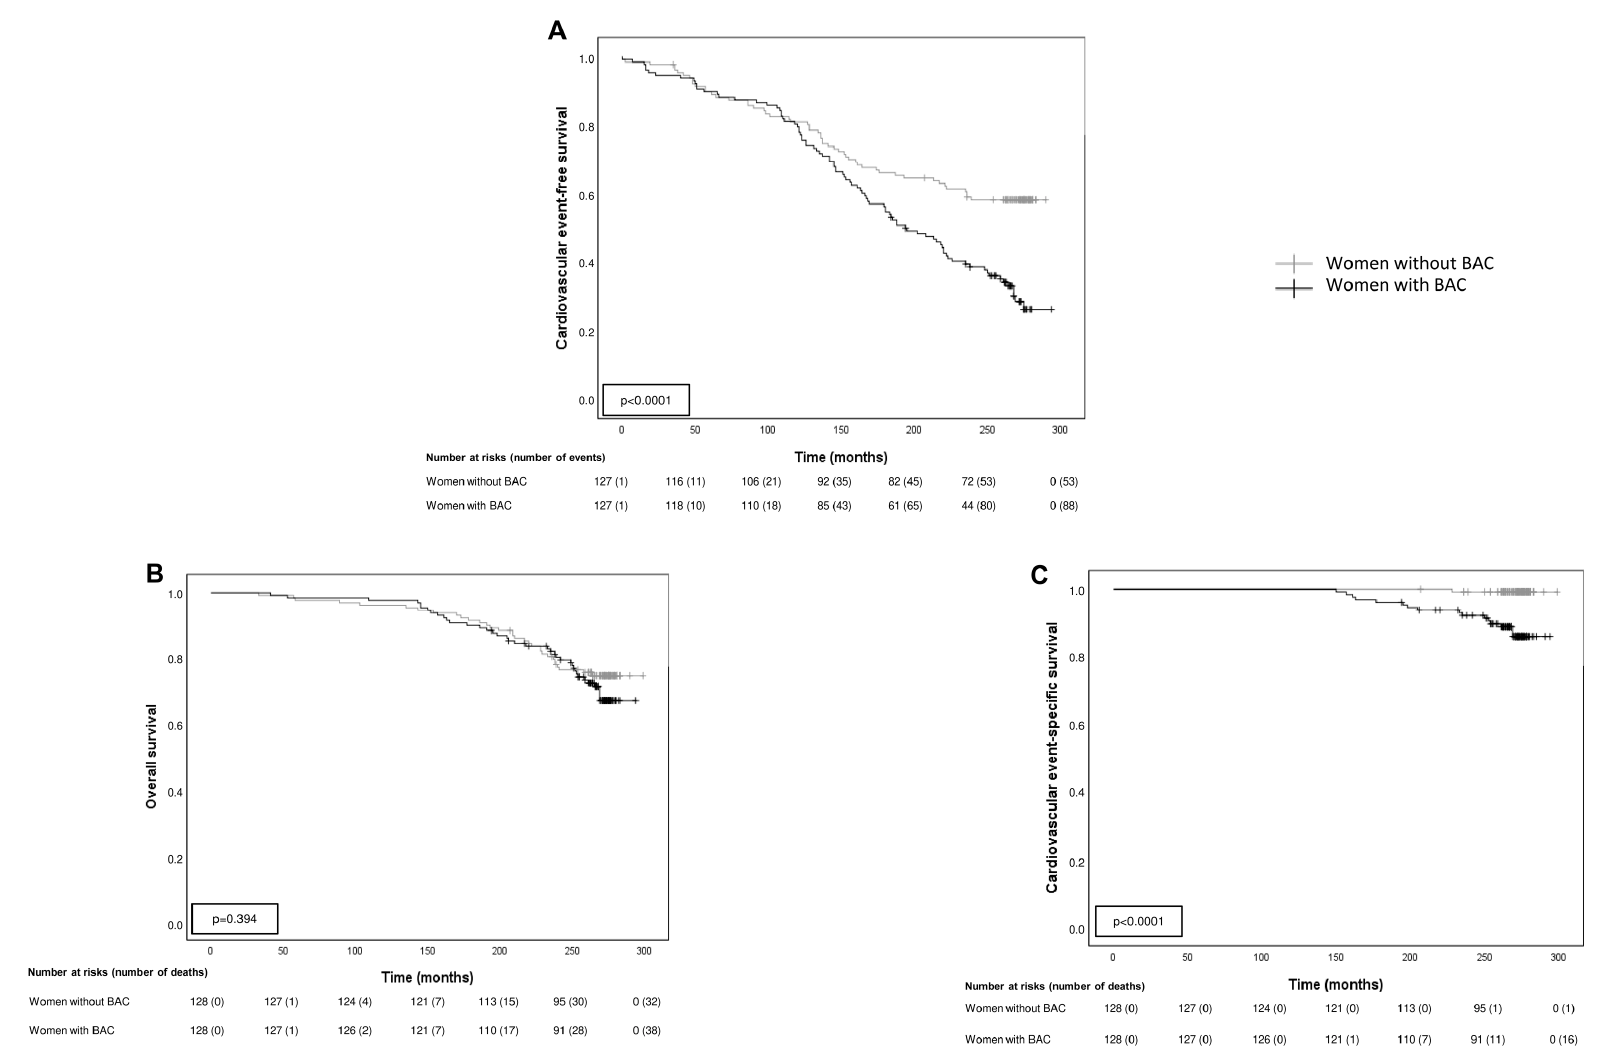
Figure 2. Kaplan-Meier survival curves. ( A ) Kaplan-Meier cardiovascular events-free survival curve as a function of patients with or without BAC. Kaplan-Meier survival curve as a function of patients with or without BAC. ( B ) overall survival and ( C ) cardiovascular event-specific